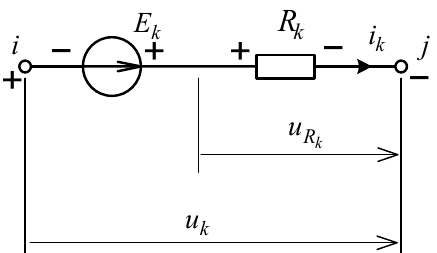
Figure 4. General branch of the circuit model with a voltage source.